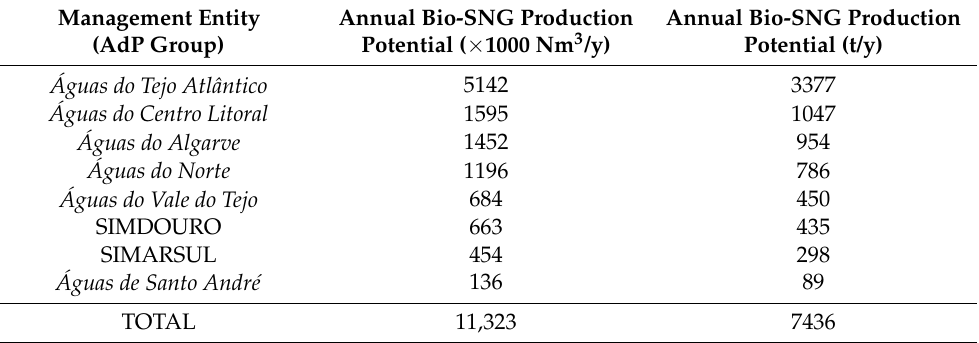
Table 6. Potential bio-SNG production values from dewatered-sludge gasification provided by management entities from AdP